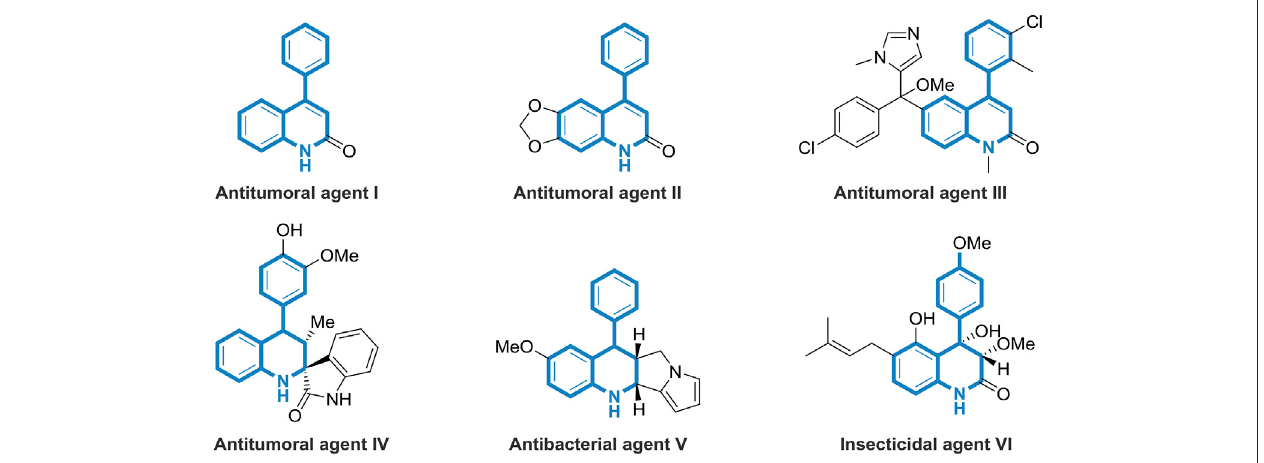
FIGURE 1 | Selected natural products and synthetic compounds containing di- or tetra-hydroquinoline frameworks.